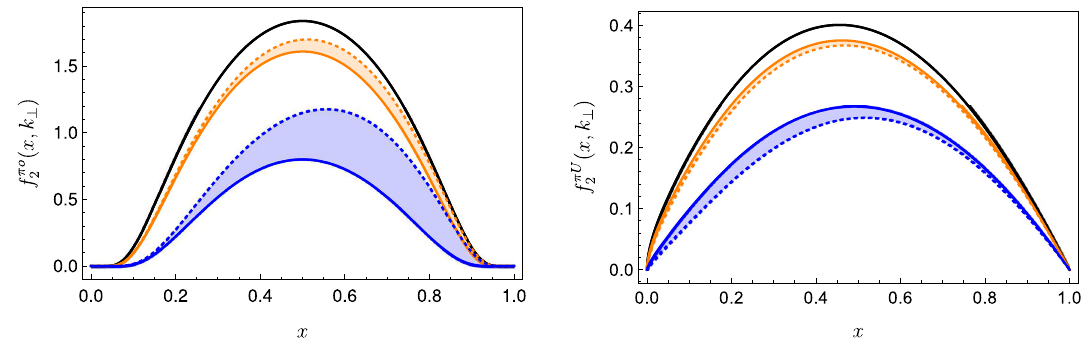
k ⊥ = 0 . 5 GeV blue lines. The bands stand for the difference between the full calculation of the dPDF and its approximation. Left panel for the original model of Ref. [34]. Right panel for the UV of Ref. [36]